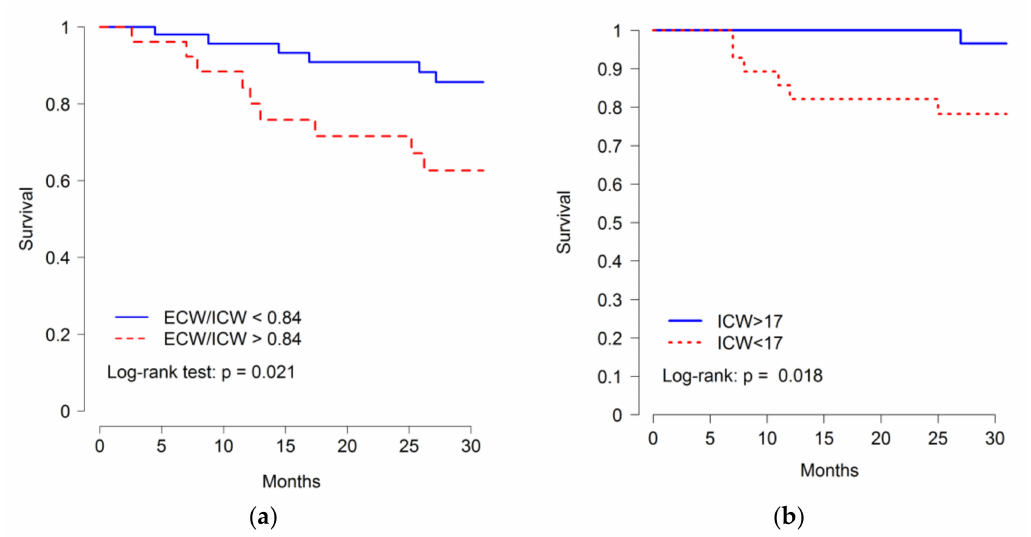
Figure 3. Kaplan–Meier curves for the time to death according to ( a ) ECW / ICW ratio and ( b ) ICW levels. Cut o ff for higher ECW / ICW ratio ≥ 0.84 and for lower ICW ≤